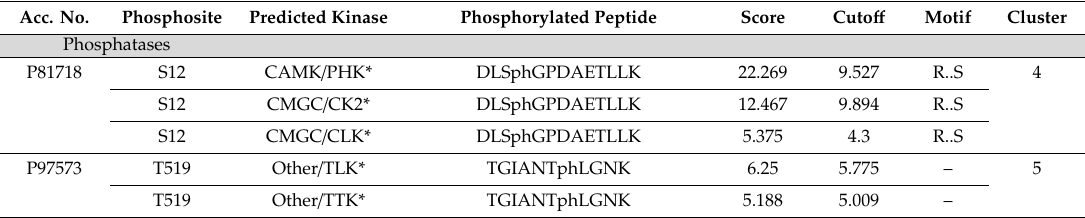
Table 4. Overrepresented KEGG pathways associated to regulated phosphoproteins. KEGG Pathway Accession No. Gene Symbol Description